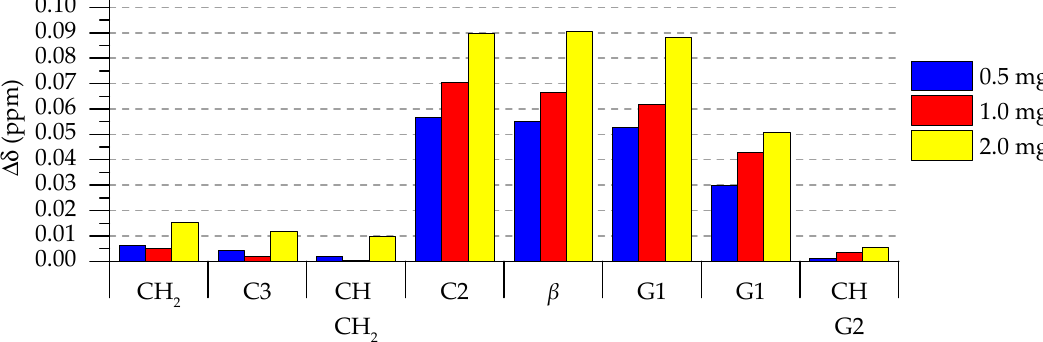
Figure A2. 1 H NMR chemical shift deltas ( ∆ δ , ppm) of E. coli lipid extracts in the presence of three different weighed amounts of tellimagrandin II 4 .